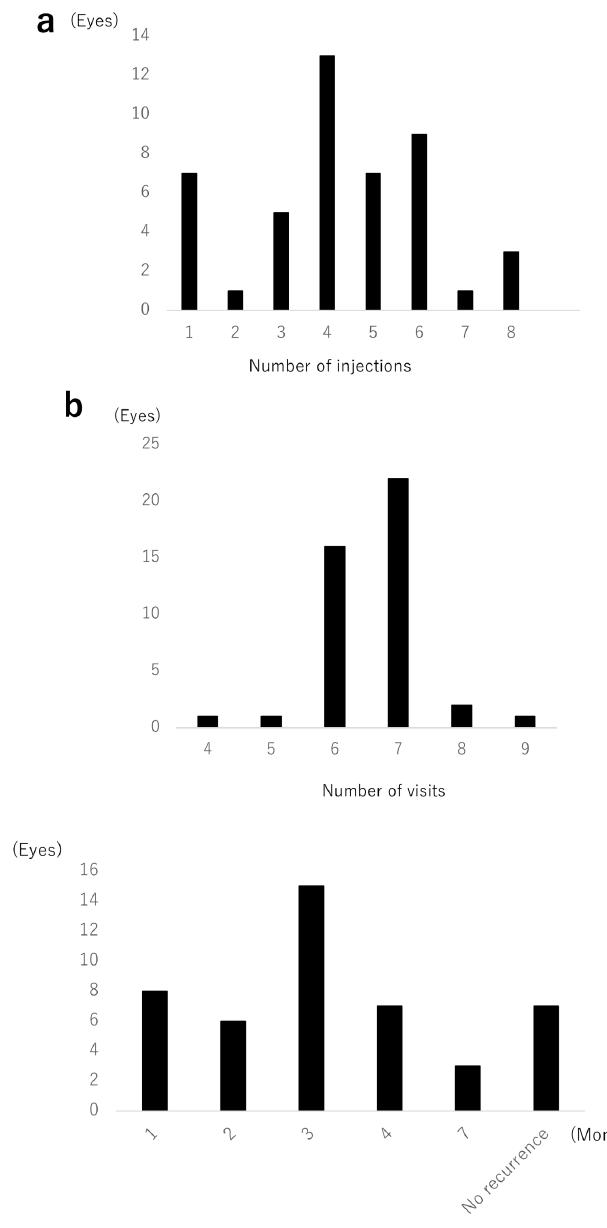
Figure 4. ( a ) Distribution of number of injections. Seven eyes (16%) received only 1 injection. The most frequent number of injections was 4 times (13 eyes, 28%). ( b ) Distribution of number of visits. The minimum was 4, and the maximum was 9 times. The most frequent number of visits was 7 times (22 eyes, 47%). ( c ) The time to first recurrence from the first injection. The first recurrence most frequently occurred at month 3 (15 eyes, 33%). Seven eyes (15%) had no recurrence.